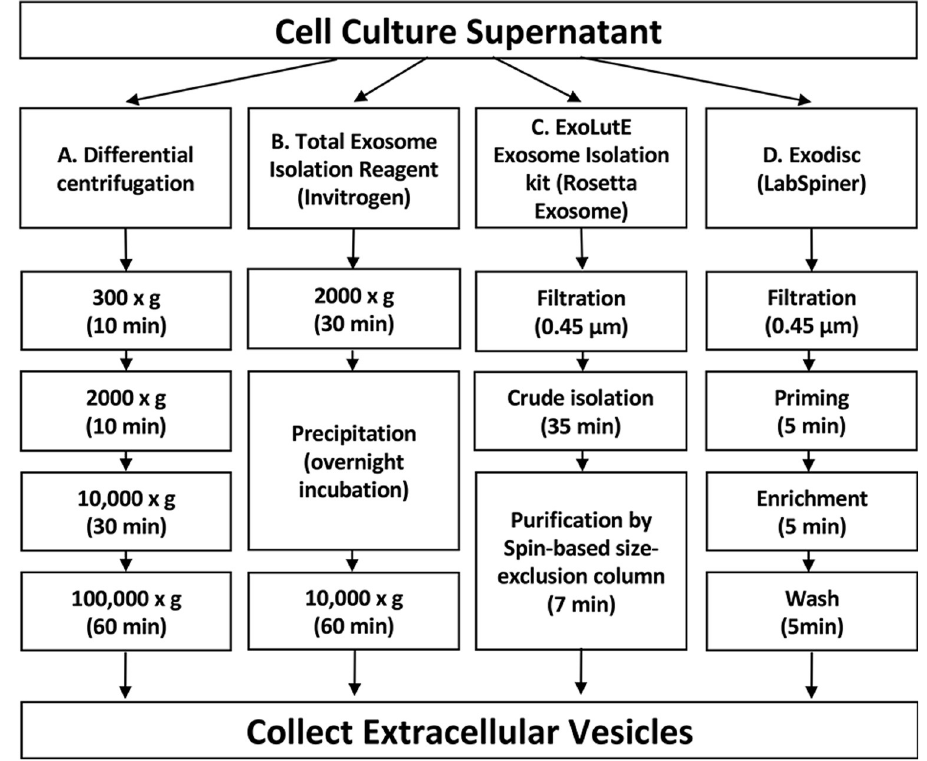
Fig 1. The schematic summary of the EV separation methods. The culture supernatant was divided into four parts of equal volumes, each for a different method. (A) Differential centrifugation: the culture supernatant was put through four centrifugation steps to separate EVs. (B) Total Exosome Isolation reagent from Invitrogen: cell debris was removed by centrifugation and EVs were separated by precipitation. (C) ExoLutE Exosome isolation kit from Rosetta Exosome: Cell debris was removed by filtration and EVs were separated by multiple processes, including spin-based size exclusion chromatography. (D) Exodisc from LabSpinner: After filtration to remove cell debris, the supernatant was applied to Exodisc with a 20 nm size-selective